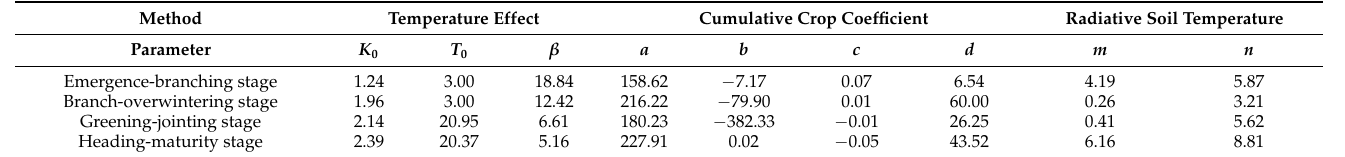
Table 2. Values of unknown parameters in different growth stages and methods of winter wheat.